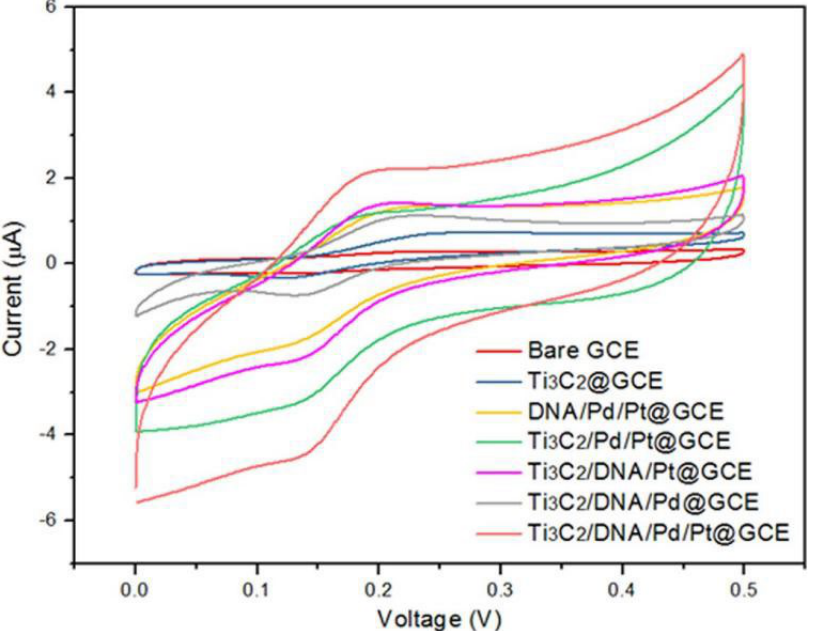
Figure 46. Cyclic voltammetry (CV) of bare GCE, Ti 3 C 2 @GCE, DNA/Pd/Pt@GCE, Ti 3 C 2 /Pd/Pt@GCE, Ti 3 C 2 /DNA/Pd@GCE, and Ti 3 C 2 /DNA/Pd/Pt@GCE in 0.1 M pH 7.0 PBS at a scan rate of 0.05 Vs −1 with 1µm DA. Reprinted with permission from [64]. Copyright 2018 Elsevier.